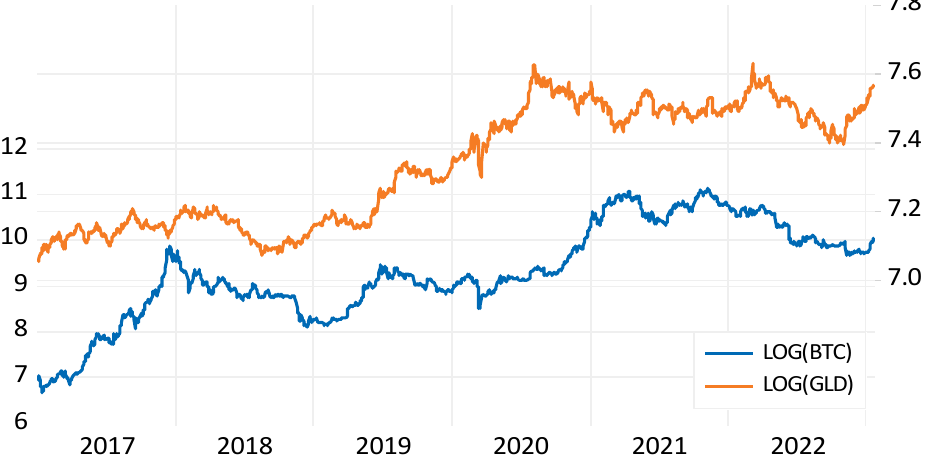
Figure 1. Price dynamics of Bitcoin and gold (in logarithmic scale) from 2 January 2017 to 20 January 2023.